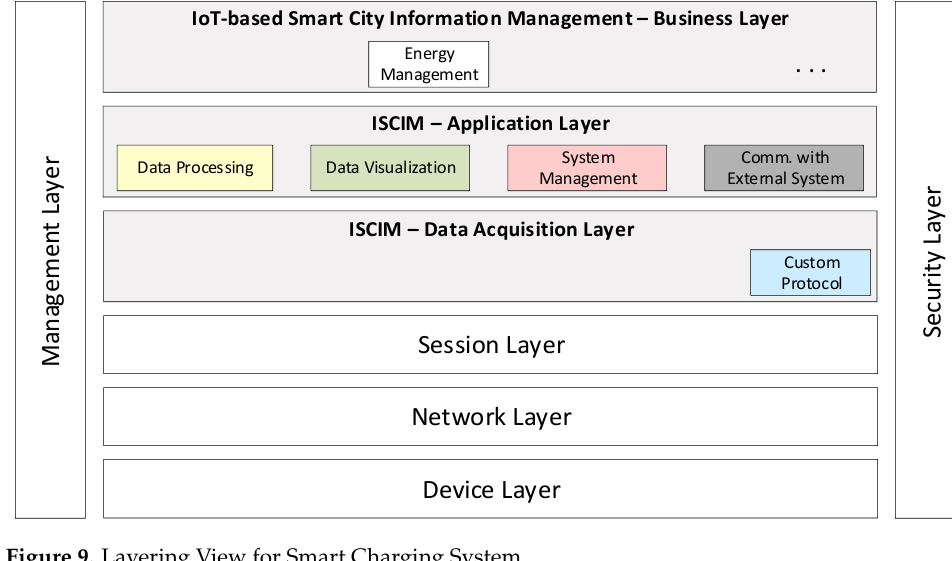
Figure 9. Layering View for Smart Charging System.